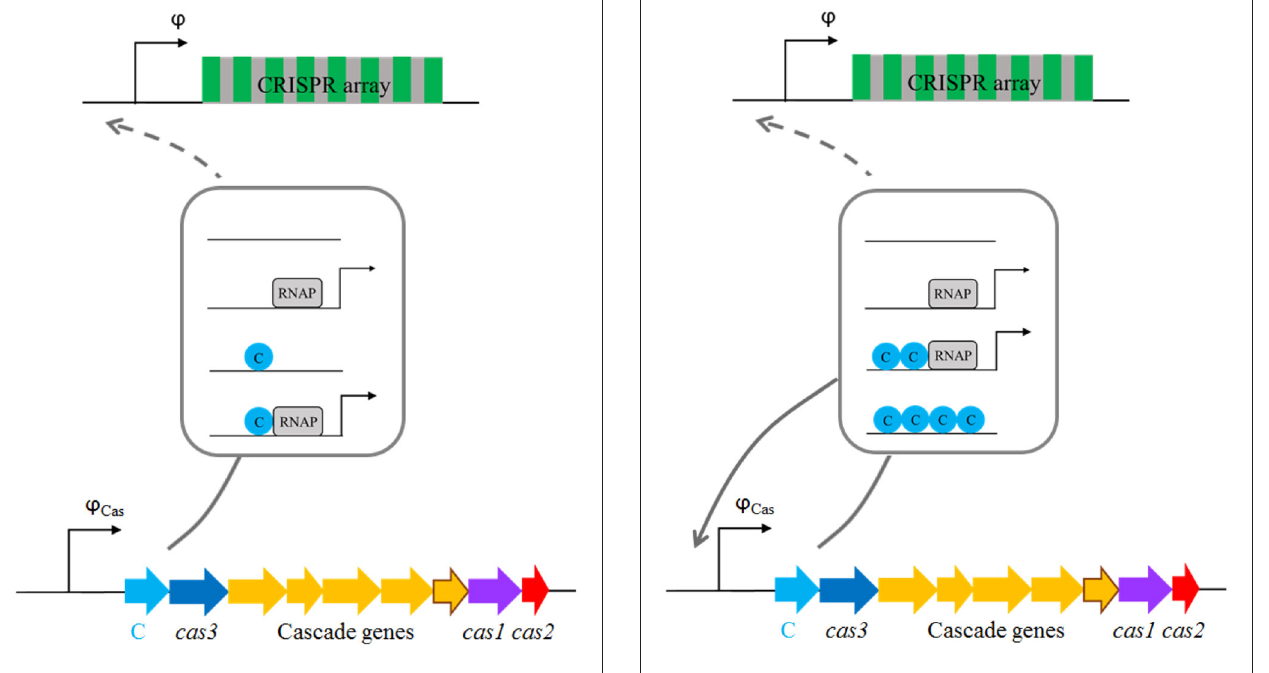
FIGURE 4 | Transcription regulation of cas and CRISPR array promoters in the constitutive model . C and cas genes are transcribed from a constitutive promoter of constant strength ϕ cas . The CRISPR array promoter is either considered constitutive, with constant transcription activity ( ϕ ), or is regulated by C protein (indicated by the dashed arrow), where a scheme corresponding to this regulation is framed. The scheme shows possible configurations of CRISPR array promoter, where activation of CRISPR array transcription is achieved in the simplest manner, through the binding of a single C protein which acts as a transcription activator to the CRISPR array promoter. Transcriptionally active configurations are denoted by arrows, with thicker arrow indicating larger transcription activity.